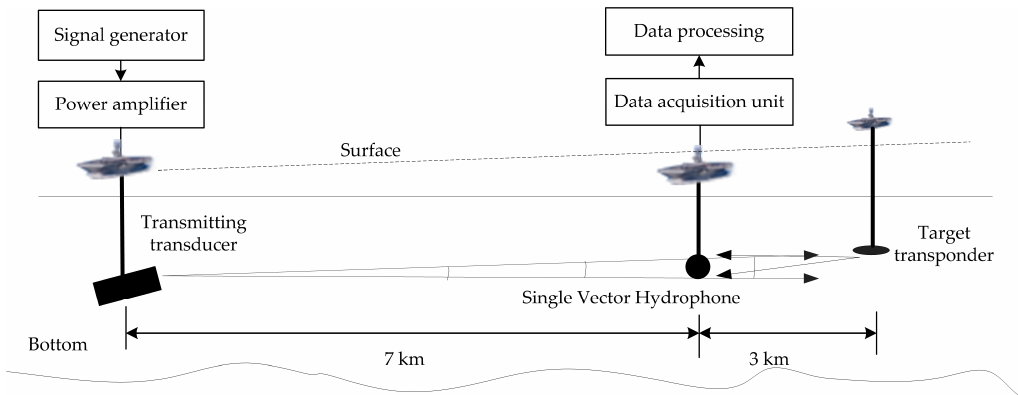
Figure 8. The schematic diagram of the open water experimental layout.